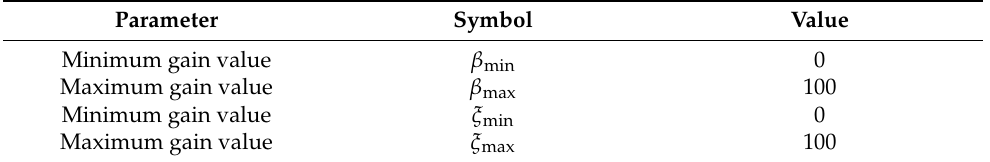
Table 1. Simplex algorithm parameters.